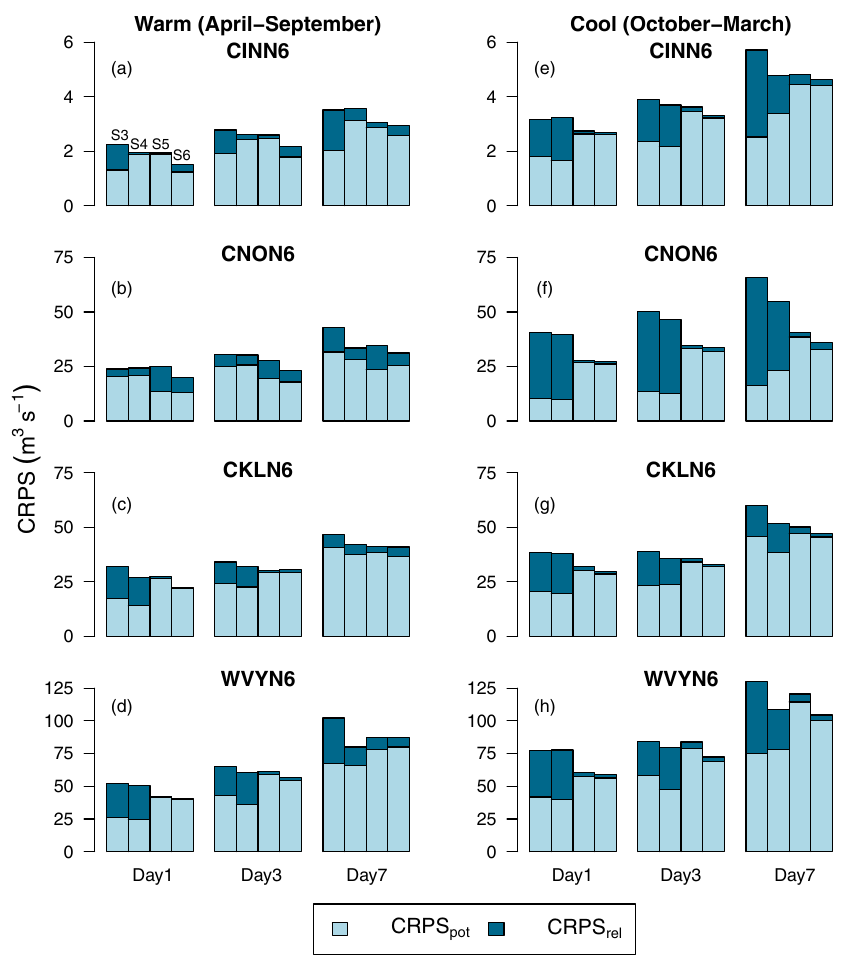
Figure 6. Decomposition of the CRPS into CRPS potential (CRPS pot ) and CRPS reliability (CRPS rel ) for forecasts lead times of 1, 3, and 7 days during the warm (a) – (d) (April–September) and cool season (e) – (h) (October–March) for the selected basins. The four columns asso- ciated with each forecast lead time represent the forecasting scenarios S3–S6 (from left to right). Note that S3 consists of GEFSRv2 + HL- RDHM, S4 of GEFSRv2 + HCLR + HL-RDHM, S5 of GEFSRv2 + HL-RDHM + QR, and S6 of GEFSRv2 + HCLR + HL-RDHM +